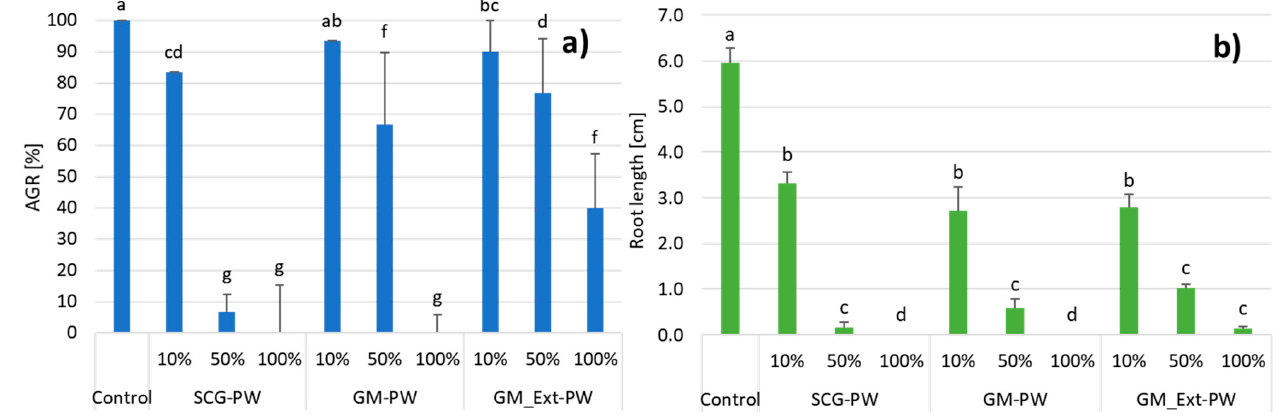
Figure 6. Germination test results using process water for ( a ) average germination rate (AGR) and ( b ) average root length. Samples connected by the same letters are not significantly different.